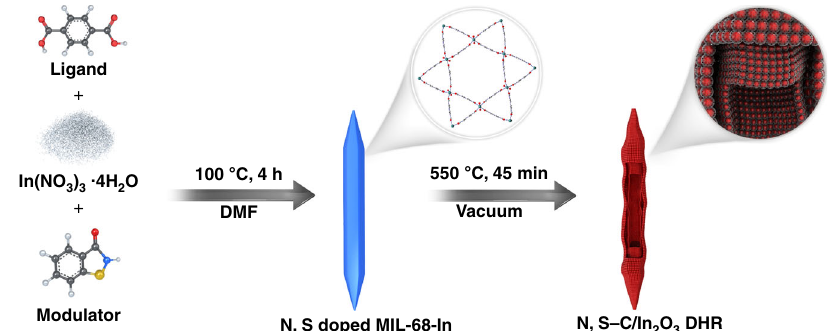
Fig. 1 Schematic illustration showing the synthetic process of monodispersed N,S-C/In 2 O 3 DHR